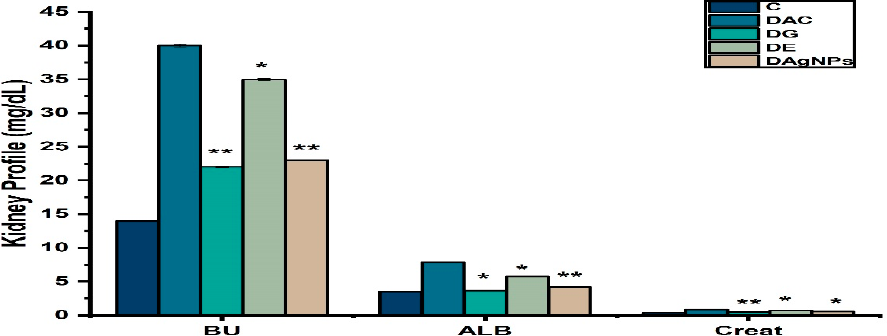
Figure 10. Liver profile of various treated groups; * p < 0.05; ** p < 0.01 reveals statistically difference between groups.